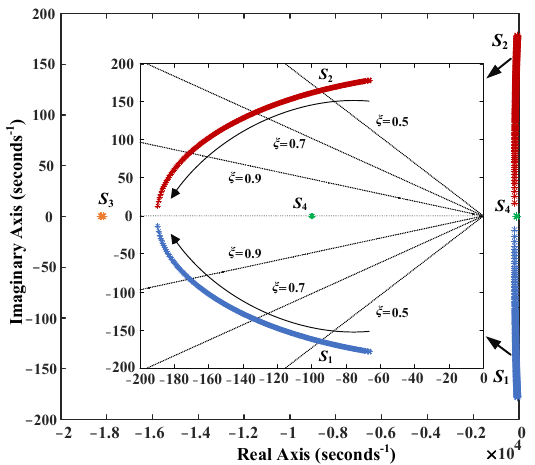
Figure 6. Characteristic root locus of the system with variation of W 3 .